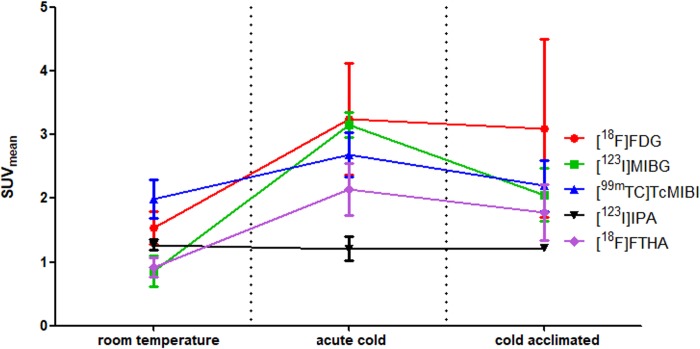
iBAT SUVmean values of [18F]FDG, [18F]FTHA, [123I]MIBG, [99mTc]MIBI and [123I]IPA in different temperature conditions.